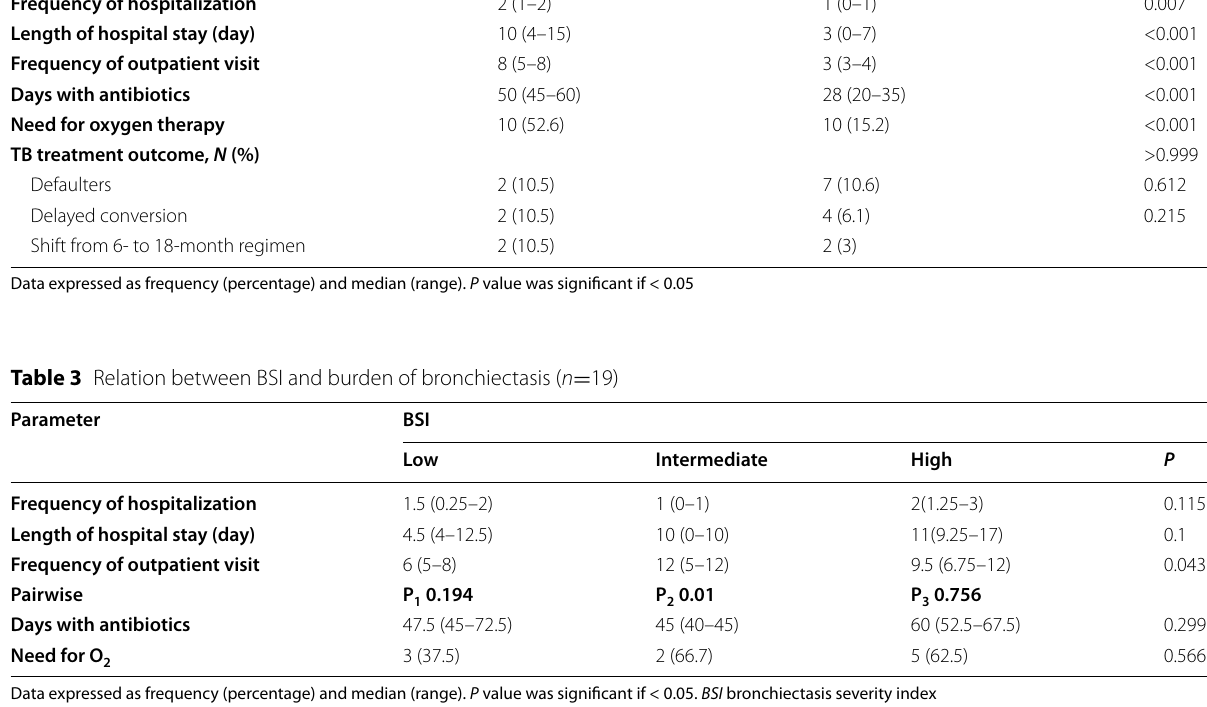
Data expressed as frequency (percentage) and median (range). P value was significant if < 0.05. BSI bronchiectasis severity index p1 the difference between low and intermediate; p2 the difference between moderate and high; p3 the difference between low and high